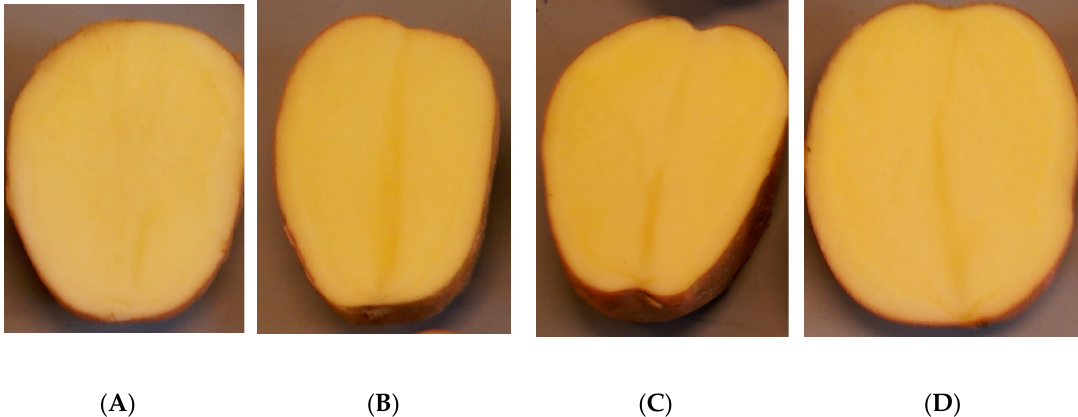
Figure 4. Shades of color brightness of raw tuber flesh cv. ‘Bellarosa’ depending on cultivation practices. ( A )—3 applications of fungicide, ( B )—3 applications, ( C )—5 applications, and ( D )—8 applications of effective organisms (EmFarmaTM plus Ema5TM).